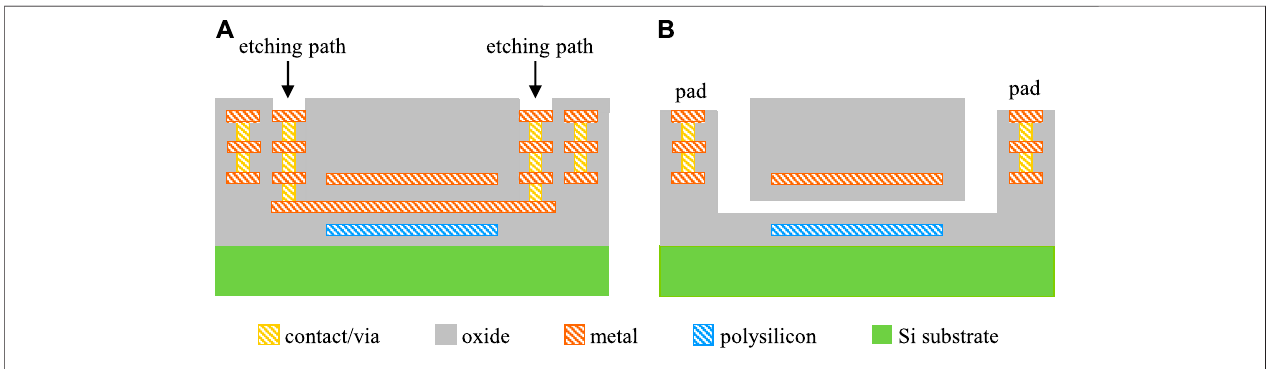
FIGURE 8 | Post-CMOS release process, (A) as-received chip, (B) after wet metal etching and laser pad opening.